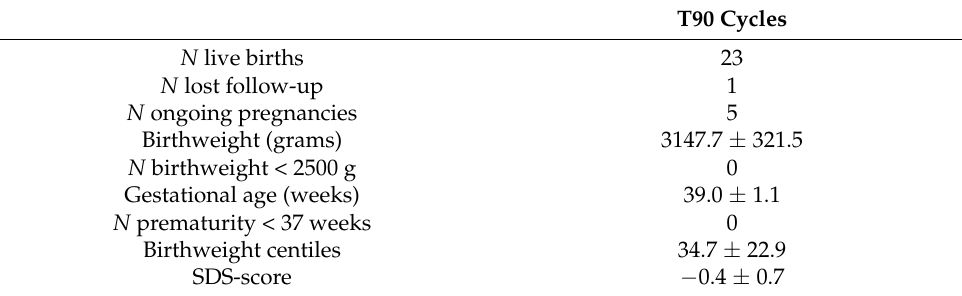
Table 5. Neonatal characteristics of live births in T90